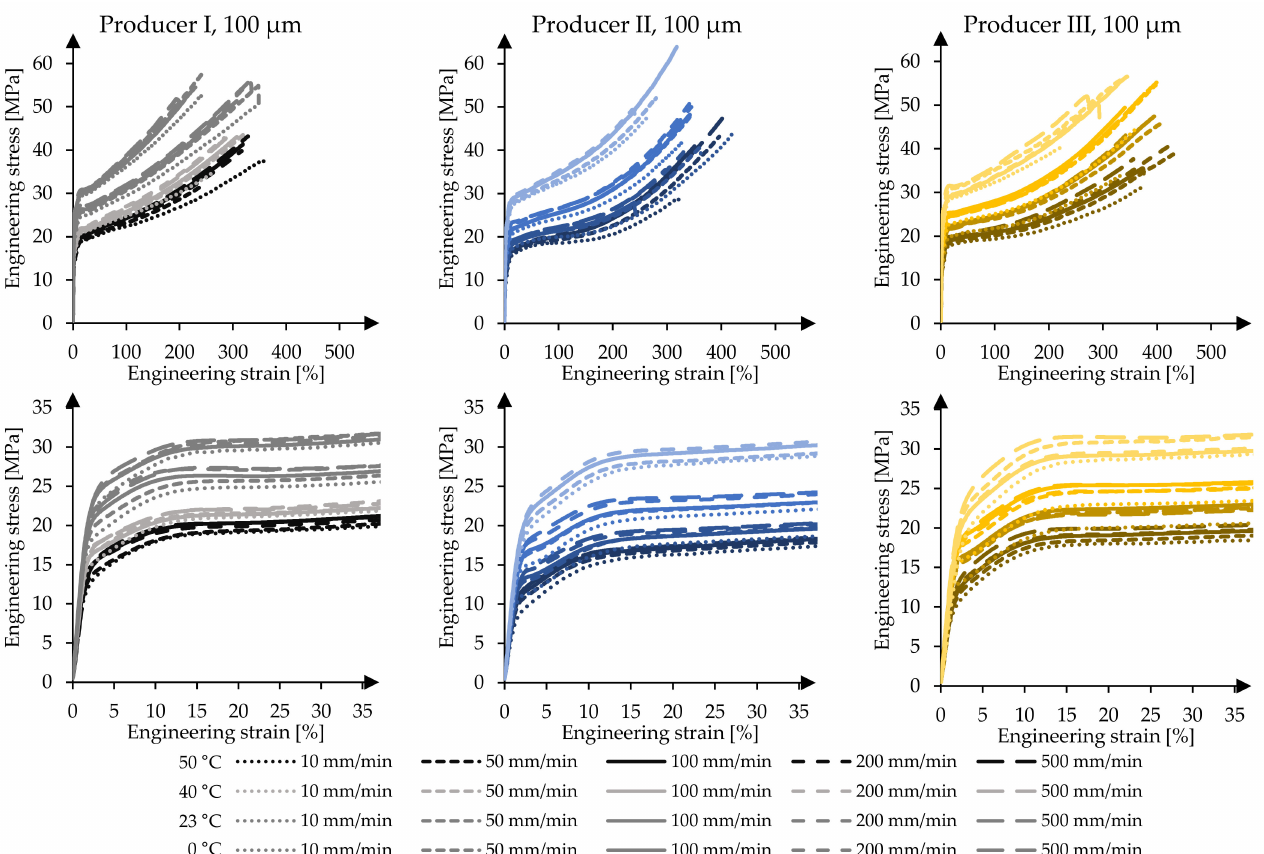
Figure 7. Mechanical response of 100 µ m ETFE foils in uniaxial tensile tests at varying test tem- peratures and test speeds as mean value curves per test series, materials of producers I, II, and III,